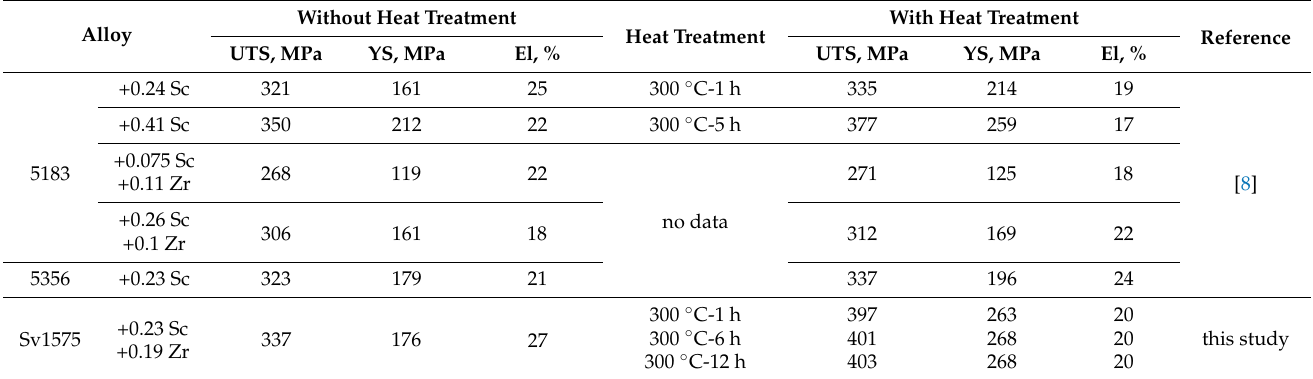
Table 7. Tensile testing results of WAAM deposits at various Sc and Zr additions to Al-Mg system welding wires.